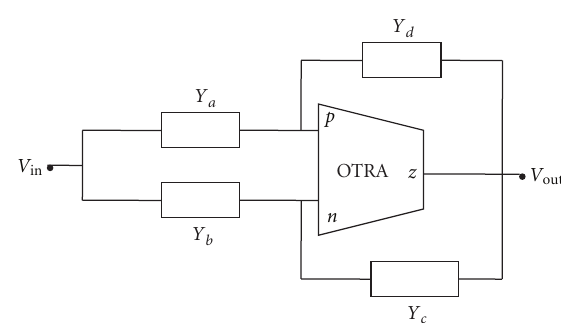
F 2: Internal circuit of OTRA [2].